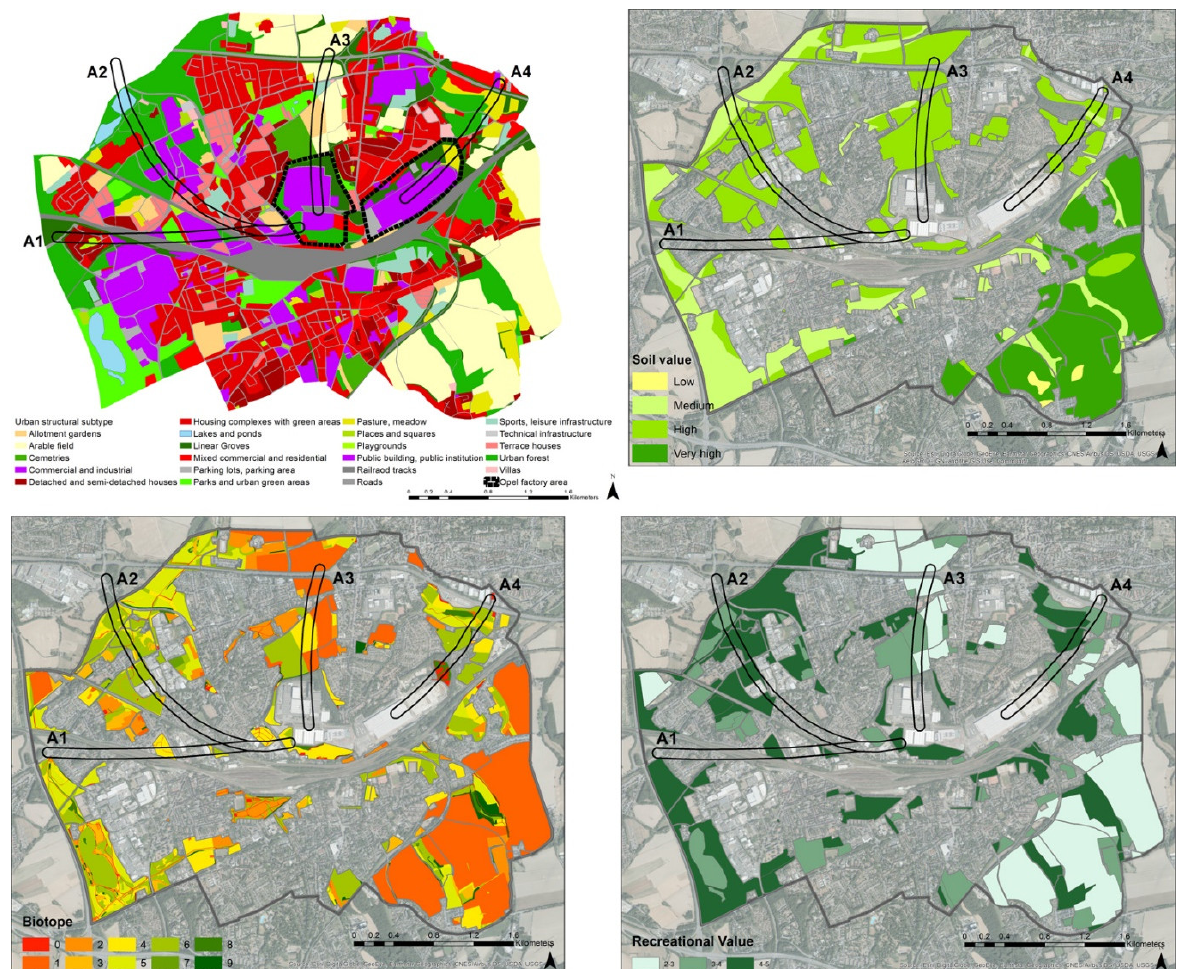
Figure 2. Urban structural subtypes in the study area ( upper left ). The areas of the European logistics centre for the distribution of spare car parts and the new industrial area are indicated with a black segmented line. The 50 m buffers of the four access roads are designated by the abbreviations A1, A2, A3 and A4. These buffers were used to calculate losses in the specific impacted areas. Soil values in open space ( upper right ). Biotopes values in open space ( down left ). Recreational values in open space ( down right ). Source: own elaboration and the assessment is based on information provided by the city of Bochum 2017 and Geological Survey NRW; satellite image as in Figure 1.